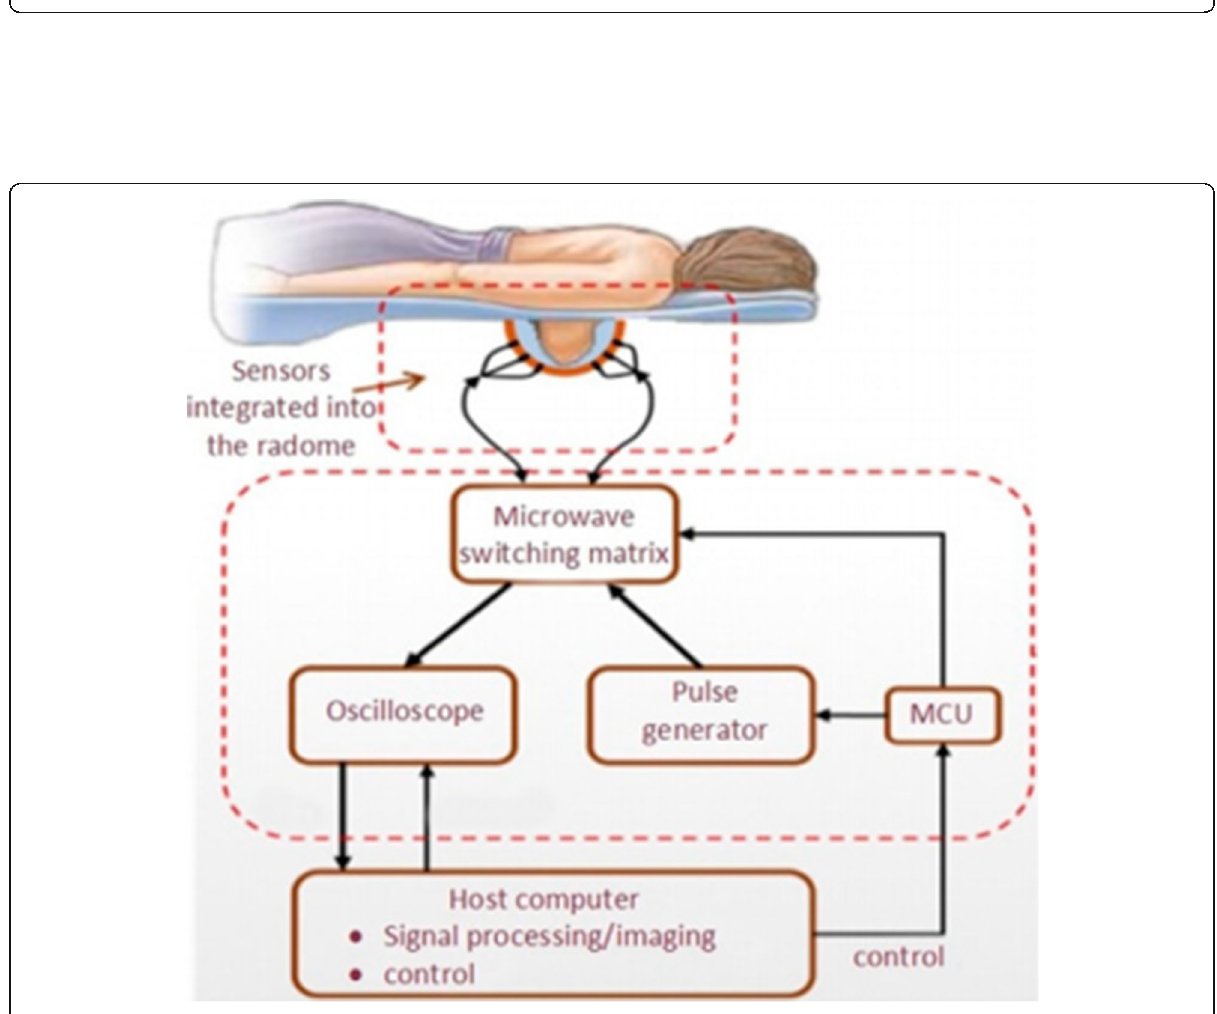
Fig. 25 All of these systems use NIR light to reconstruct images of hemoglobin, oxygen saturation, water, and scattering values through the breast [44]